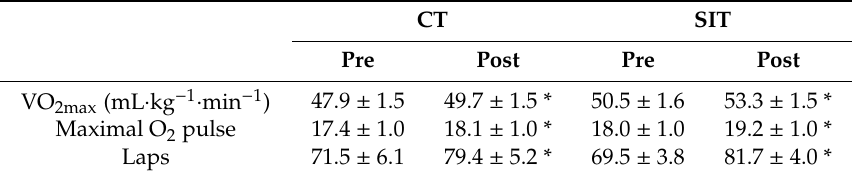
Table 1. Parameters of maximal endurance performance before and after eight weeks of continuous training (CT) and sprint interval training (SIT). CT SIT Pre Post Pre Post VO 2max (mL · kg − 1 · min − 1 ) 47.9 ± 1.5 Maximal O 2 pulse 17.4 ± 1.0